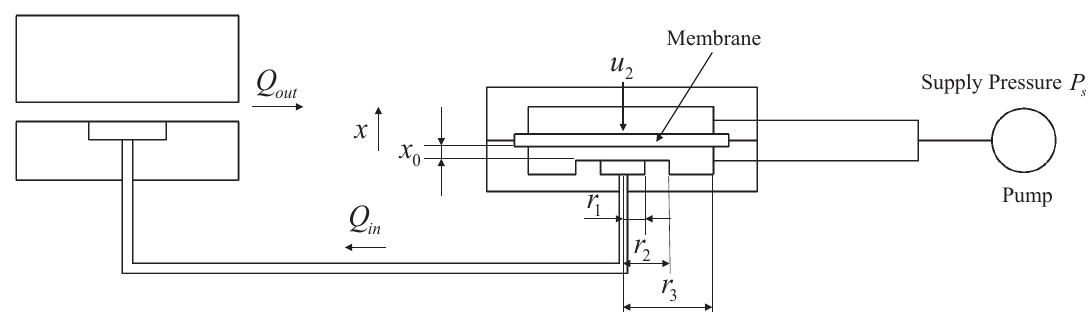
Figure 2. Schematic of hydrostatic thrust bearing compensated with a membrane